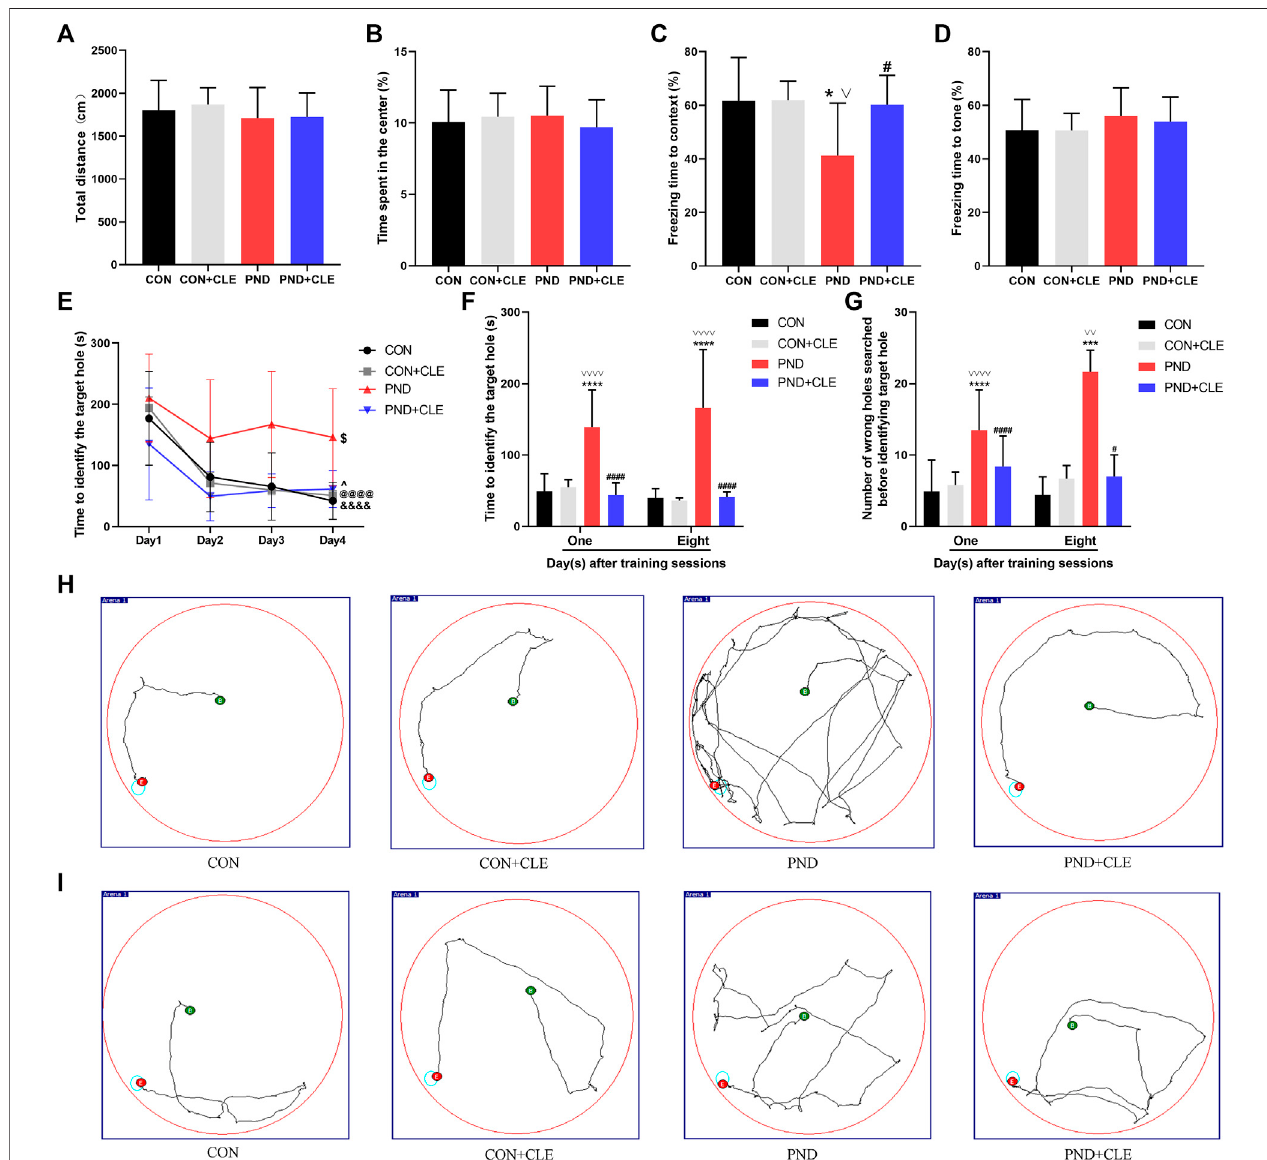
FIGURE 2 | Anesthesia and surgery-induced cognitive impairments were ameliorated by clemastine treatment. ( A ) Total distance in the open fi eld test among four groups. ( B ) Time spent in the center of open fi eld test among four groups. ( C ) Context test in the fear conditioning test among four groups. ( D ) Tone test in the fear conditioning test among four groups. ( E ) Performance during the training phase of the Barnes maze. ( F, G ) Performance during the testing phase of Barnes maze. ( H, I ) Representative movement traces on day 1 and day 8 of the Barnes maze test phase. The data are presented as mean ± S.D. ( n (cid:1) 20 mice per group). * p < 0.05 compared with the CON group. *** p < 0.005 compared with the CON group. **** p < 0.001 compared with the CON group. # p < 0.05 compared with the PND group. #### p < 0.001 compared with the PND group. ∨ p < 0.05 compared with the CON + CLE group. ∨∨ p < 0.01 compared with the CON + CLE group. ∨∨∨∨ p < 0.001 compared with the CON + CLE group. &&&& p < 0.001 compared with the day 1 in CON group. @@@@ p < 0.001 compared with the day 1 in CON + CLE group. $ p < 0.05 compared with the fi rst day in PND group. ^ p < 0.05 compared with the fi rst day in PND + CLE group.